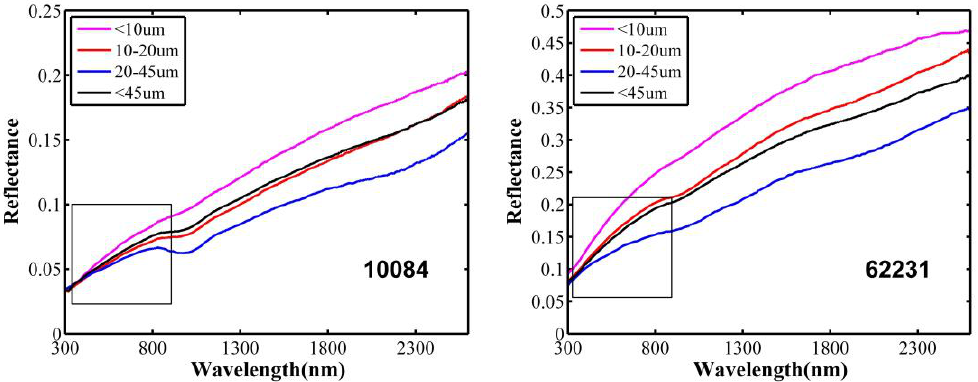
Figure 1. Reflectance spectra of four grain size groups of lunar soil samples 10084 and 62231. Black squares show the convergence of reflectance spectra at short wavelengths.